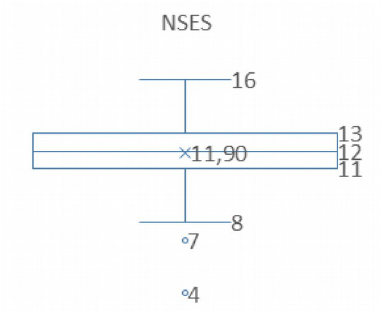
Figure 2. Box plot for the NSES